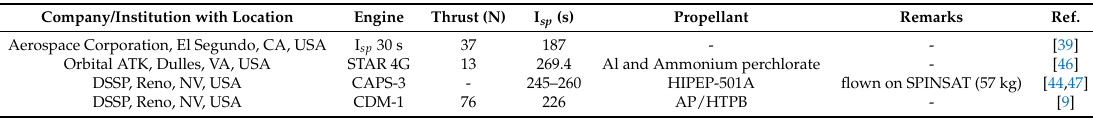
Table 3. Summary of Solid Propulsion